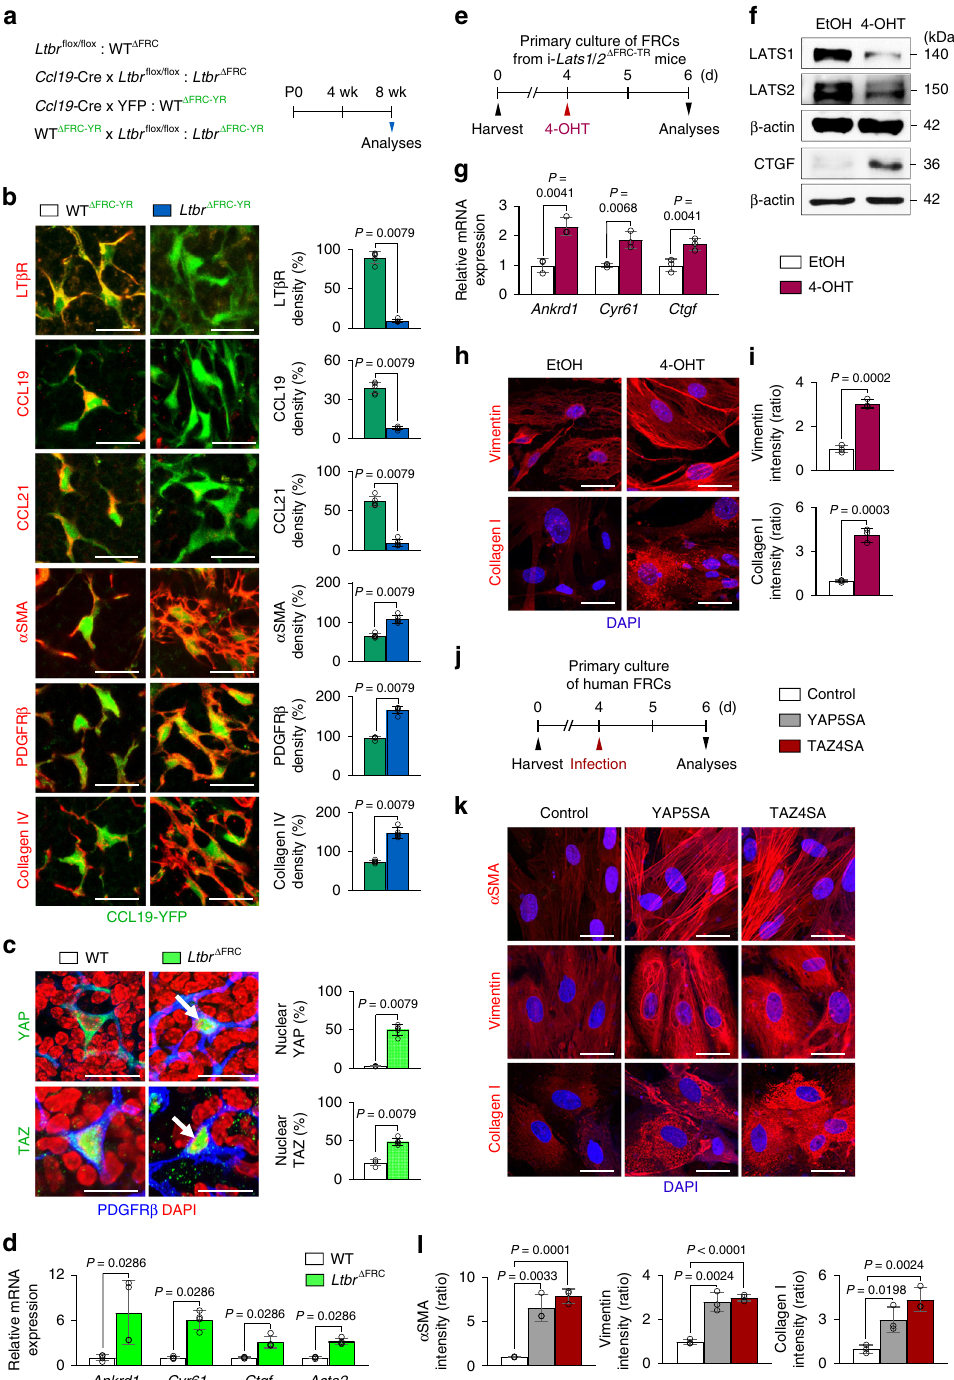
Histological analyses . Gross images of LNs were acquired using AxioZoom V16 stereo zoom microscope (Carl Zeiss). For LN weight measurement, bilateral inguinal LNs were pooled and weighed using an analytical balance (Mettler Toledo). For immuno fl uorescence staining of LNs, harvested samples were fi xed in 1% paraformaldehyde (PFA) in PBS overnight at 4°C and dehydrated in 20% sucrose in PBS overnight at 4°C. Samples were embedded in tissue freezing medium (Leica) and frozen blocks were cut into 20- μ m-thick sections. Samples were blocked with 5% goat (or donkey) serum in 0.3% Triton X-100 in PBS (PBST) and incubated for overnight at 4°C with primary antibodies (diluted at a ratio of 1:200 in blocking solution). After several washes with PBS, samples were incubated for 2 h at RT with secondary antibodies (diluted at a ratio of 1:1000 in blocking solution). After washing several times with PBS, samples were mounted with fl uorescent mounting medium (DAKO) and images were acquired using LSM780 or LSM880 confocal microscope (Carl Zeiss).